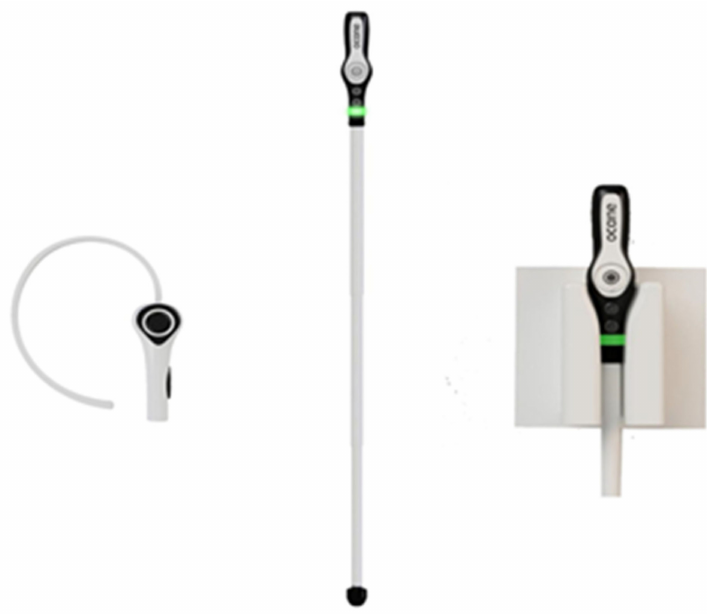
Figure 9. Rendering of earpiece, cane, and magnetic induction charging system.